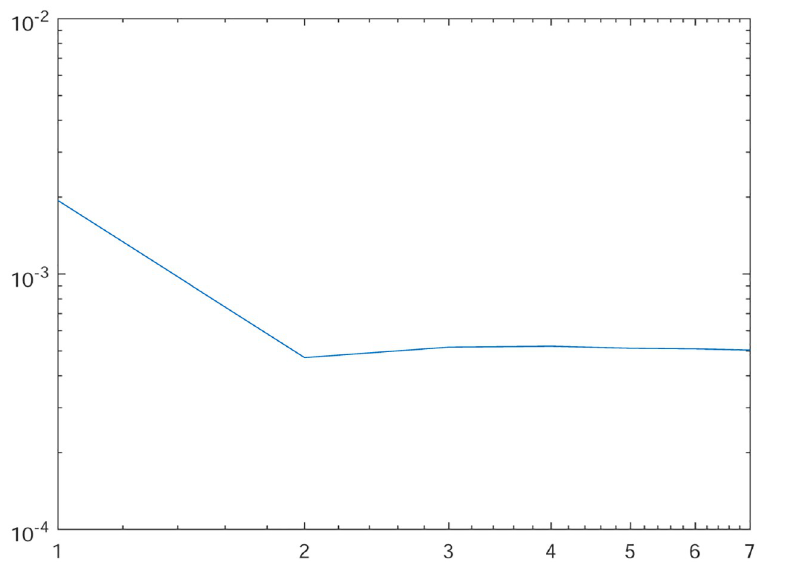
Fig 7. The behavior of the error with respect to the parameter γ for the Experiment 3.